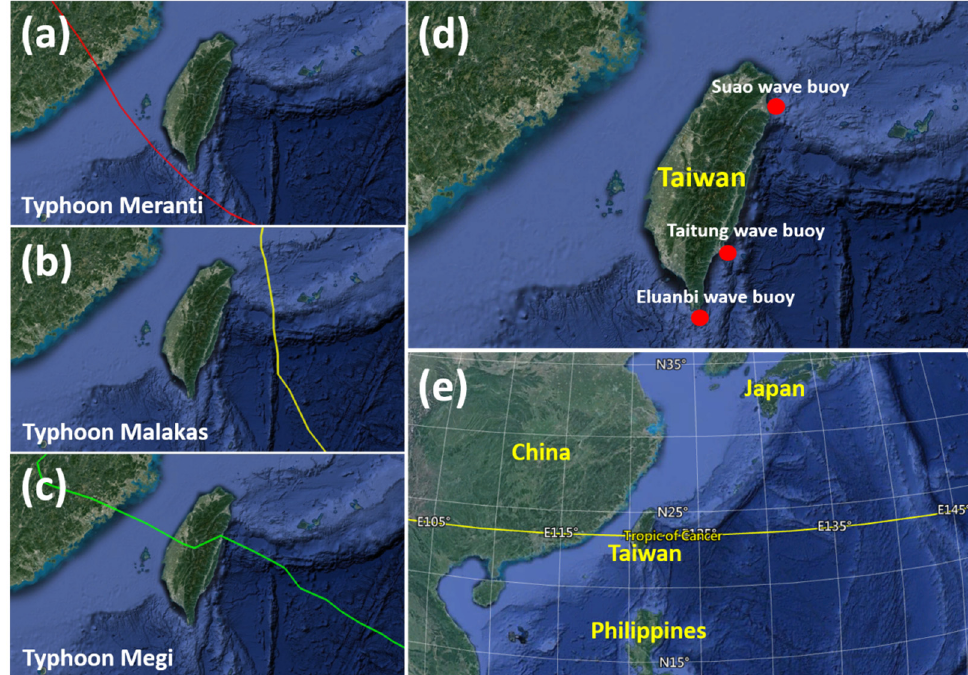
Figure 1. Tracks of ( a ) Typhoon Meranti (12 to 15 September), ( b ) Typhoon Malakas (15 to 18 September), and ( c ) Typhoon Megi (25 to 28 September); ( d ) locations of the wave buoys and ( e ) the computational domain (105° E–140° E, 15° N–32° N) for the present study.